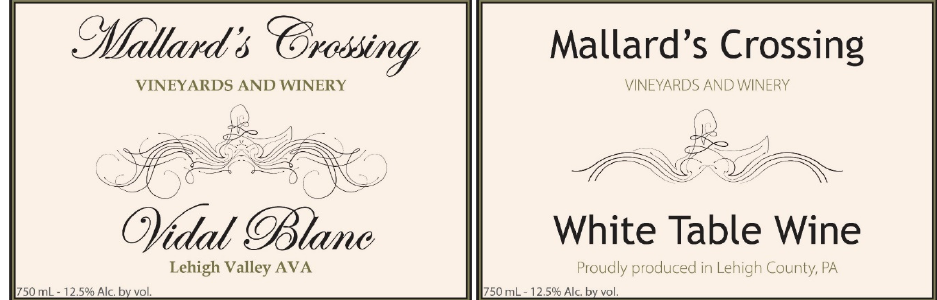
Figure 1. Two example wine labels used in the choice-based conjoint analysis (CBCA) experiment displaying variations in wine type, production location, font, and primary image. displaying variations in wine type, production location, font, and primary